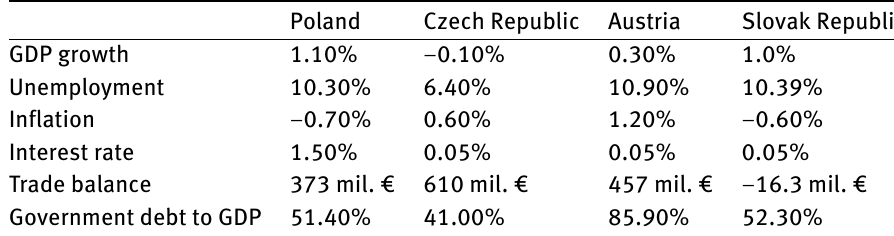
Table 1: Up-to-date economic indicators of chosen countries.